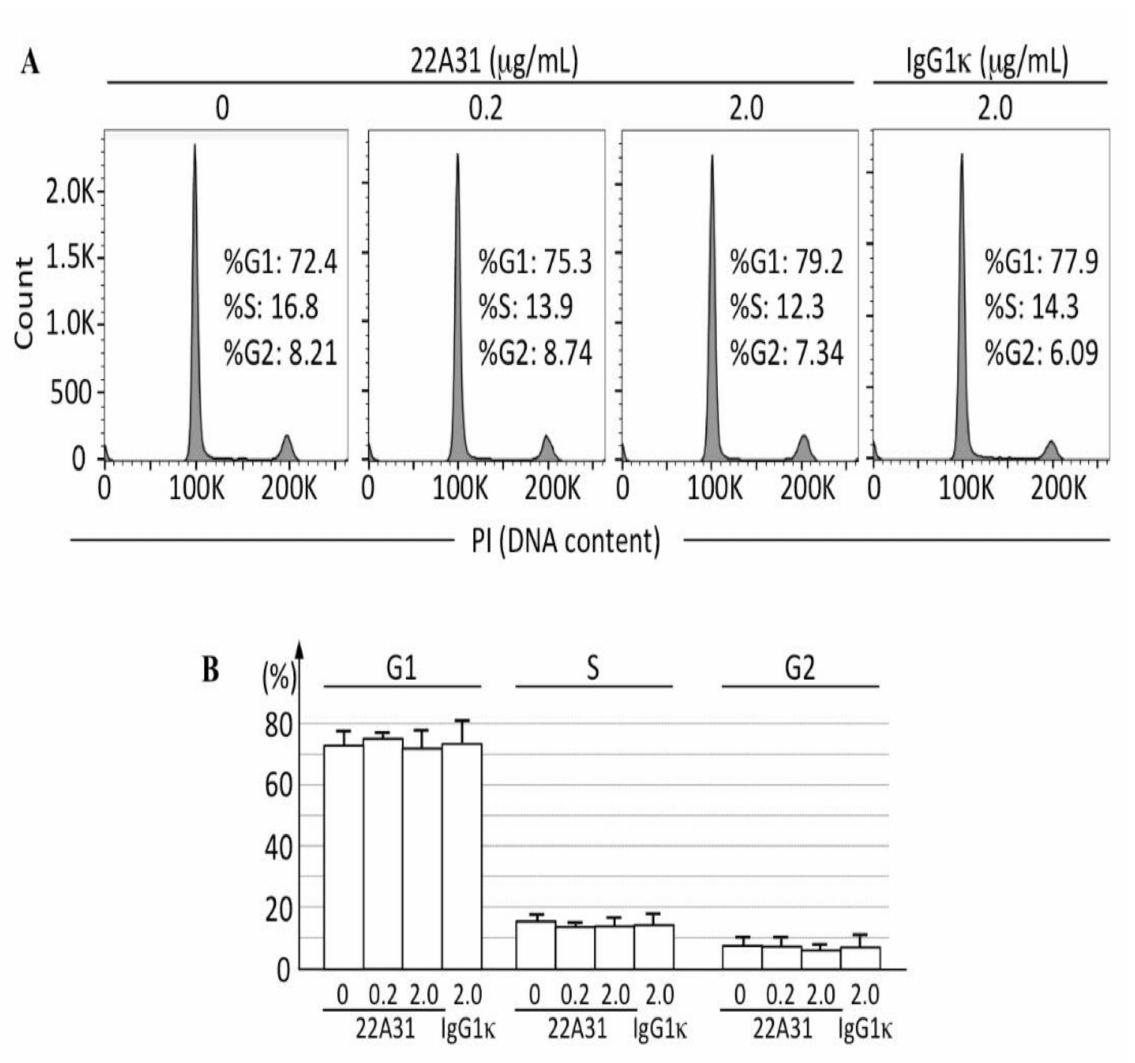
Figure 4. Cell cycle analyses of HCT116 cells after treatment with 22A31. The percentage of G1, S, and G2 populations were analyzed by flow cytometry. ( A ) Representative histograms. ( B ) Quantified data of G1, S, and G2 populations (mean ± SD) in three experiments. HCT116 cells were incubated with 0, 0.2 and 2.0 µ g/mL 22A31 at 37 ◦ C for 48 h. As a negative control, 2.0 µ g/mL IgG1 κ was